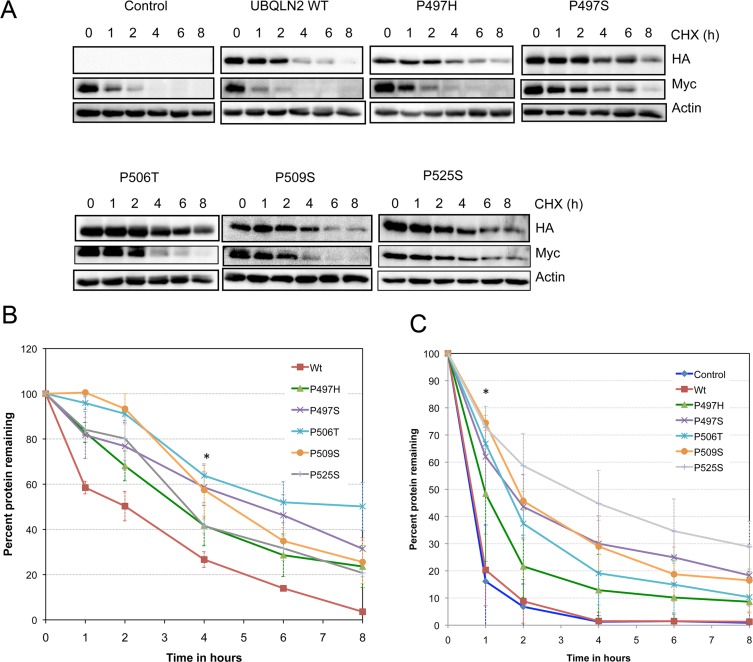
Ubiquilin-2 proteins containing ALS mutation have increased stability and they slow degradation of Myc protein.(A) Similar to Fig 1, except that 1 hrs following transfection the cells were trypsinized from the dishes and replated equally into six plates. 20 hrs later, cycloheximide (CHX) was added for the periods indicated and equal amounts of protein lysates from the cultures were immunoblotted for HA, Myc, and actin. (B) Graph illustrating differences in turnover of the different HA-tagged ubquilin-2 proteins. The turnover of all of the mutants, with the exception of P497H, was slower than WT ubiquilin-2 at the 4 hr time point (* p = <0.05). (C) Similar to B, but showing quantification of Myc protein turnover. Myc protein turnover was significantly slower at the 1 hr time point for cells transfected with all of the mutants, but not WT ubiquilin-2 cDNA (p = 0.05).